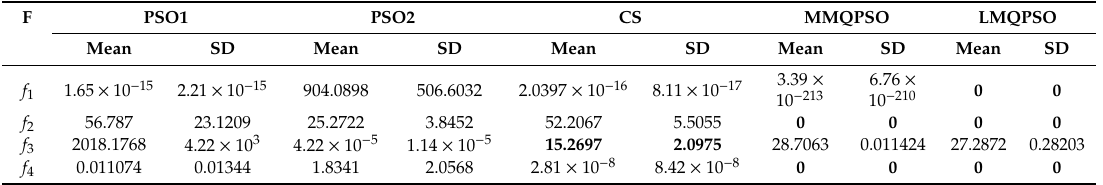
Figure 5. Comparison Results of PSO1, PSO2, CS, MMQPSO and LMQPSO. Table 2. Comparison results of five optimization algorithms on four benchmark functions at dimension 30 through 10 independent runs.